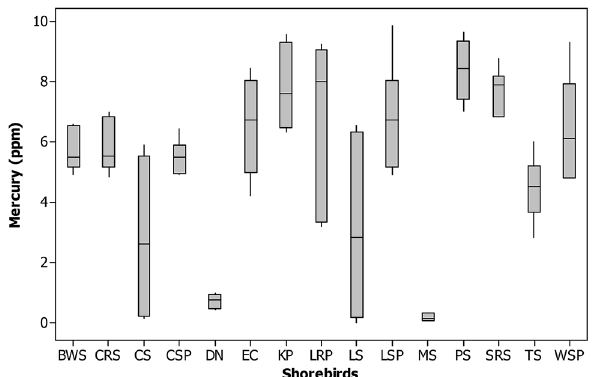
Figure 2. Box plot showing the concentration of mercury (ppm) recorded in different shorebird species at Point Calimere Wildlie Sanctuary, Kodikkarai and Pichavaram Mangrove Forest, Pichavaram, east coast of Tamil Nadu, India. (Shorebirds: BWS black winged Stilt; CRS common red shank; CS common sandpiper; CSP curlew Sandpiper; DN Dunlin; EC Eurasian Curlew; KP kentish plover; LRP little ringed plover; LS little stint;